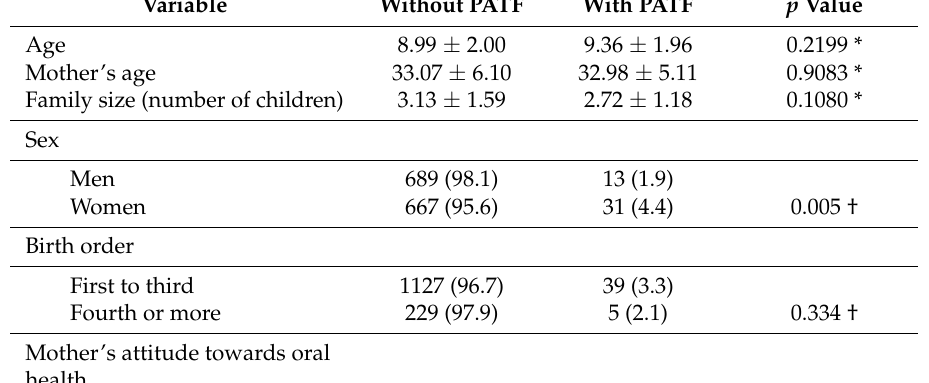
Table 2. Bivariate results for visits to the dentist for PATF in children from 6 to 12 years of age.